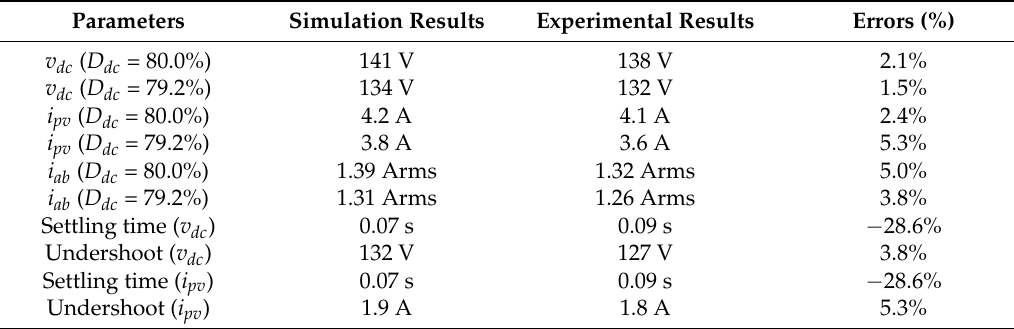
Table 2. Experimental results for model